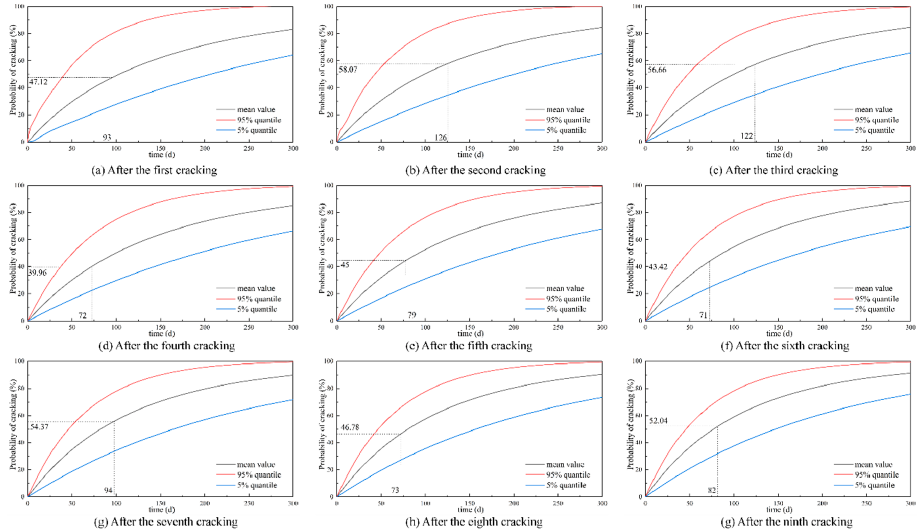
Figure 13. The estimated mean value and confidence interval of cracking probability based on the distribution of λ updated with the information on last crest cracking event, as well as the observed next cracking time and the corresponding computed mean value of cracking probability.